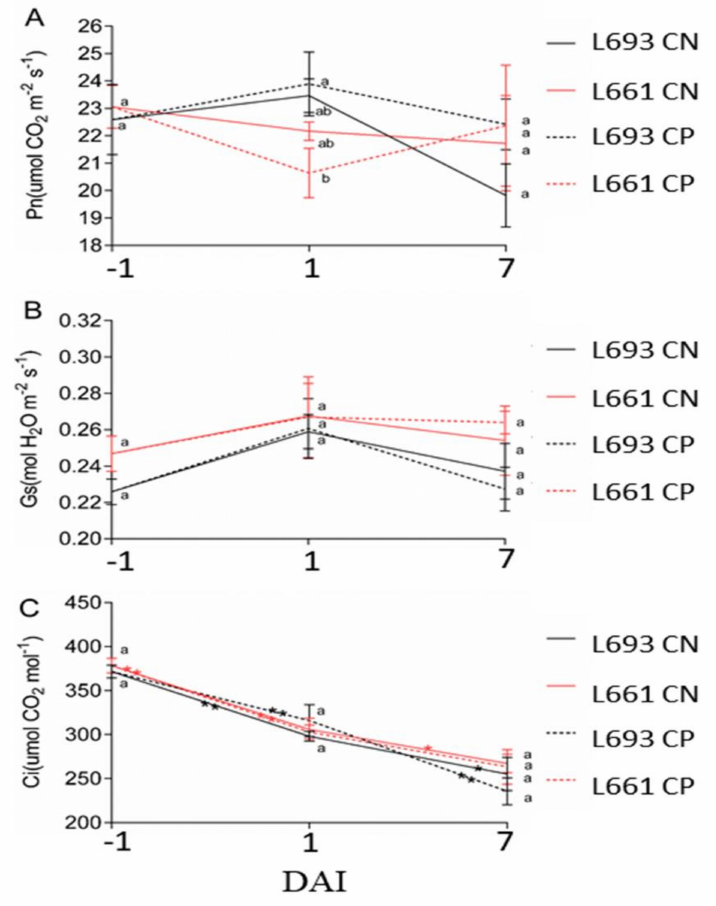
Figure 3. Changes in photosynthesis parameters of plants in the greenhouse. ( A – C ) represent changes in the Pn , Gs , and Ci in the greenhouse, respectively. Pn − the net photosynthesis rate, Gs − stomatal conductance, and Ci − the intercellular CO 2 concentration. CN − cutting no leaves; CP − cutting some leaves (flag leaf remains). The asterisks represent statistically significant differences, as follows: ** p < 0.01 and * p < 0.05. An asterisk on the trend line represents the difference between two adjacent time points for the same genotype and treatment. The same lowercase letter(s) at each time point are not significantly different at the 5% probability level in different genotypes and